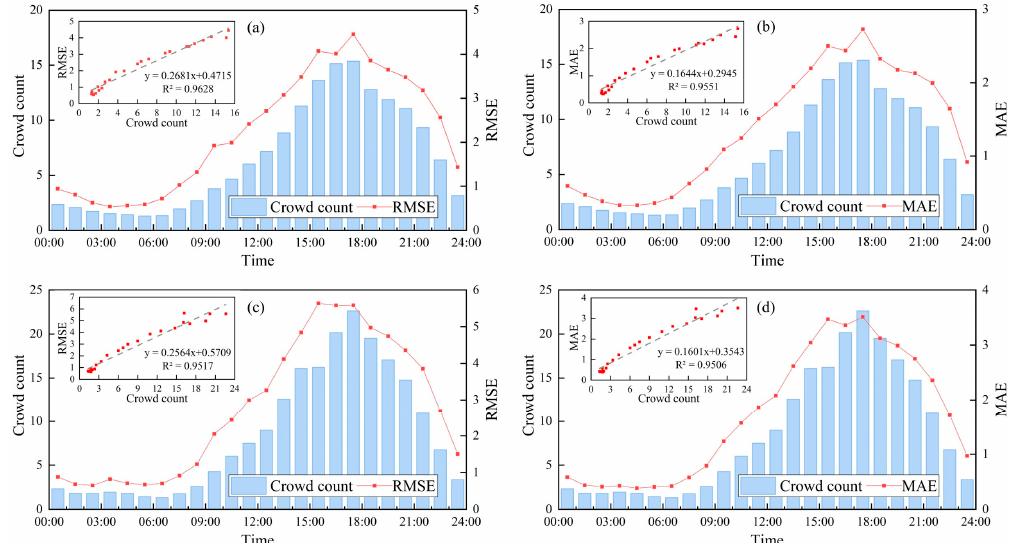
Figure 6. The relationship between mean crowd count and ( a ) RMSE on weekdays; ( b ) MAE on weekdays; ( c ) RMSE on weekends; ( d ) MAE on weekends.